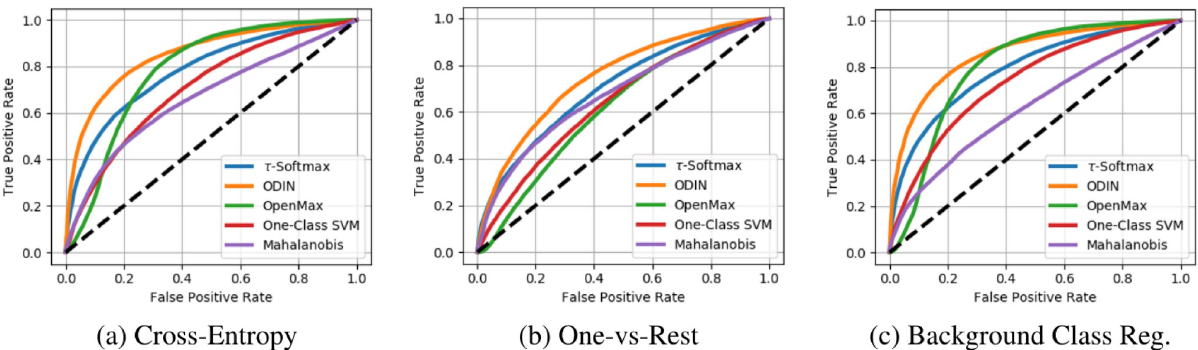
Fig 6. Intra-dataset ROC curves. Full ROC curves across the range of OOD detection thresholds for the Intra-Dataset (ImageNet-Open) experiment.